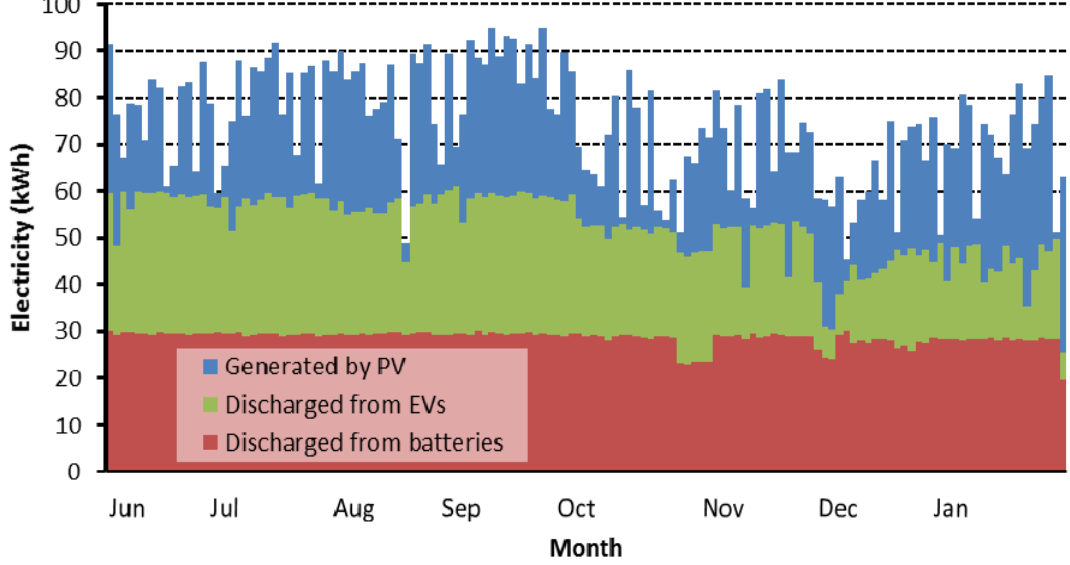
Figure 10. The amount of peak-cut and peak-shift in a day by each PV, EVs, and used EV batteries.